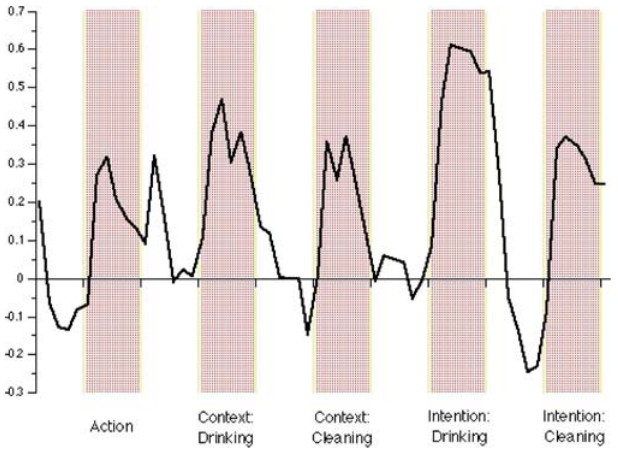
Figure 4. Time Series of the Inferior Frontal Area Showing Increased Signal in the Comparisons Intention minus Action and Intention minus Context The drinking Intention condition yielded a much stronger response than the cleaning Intention condition ( p , 0.003), whereas no reliable difference was observed between the drinking and cleaning Context conditions ( p . 0.19). The time series represents the average activity for all subjects in all voxels reaching statistical threshold in the right inferior frontal cortex.